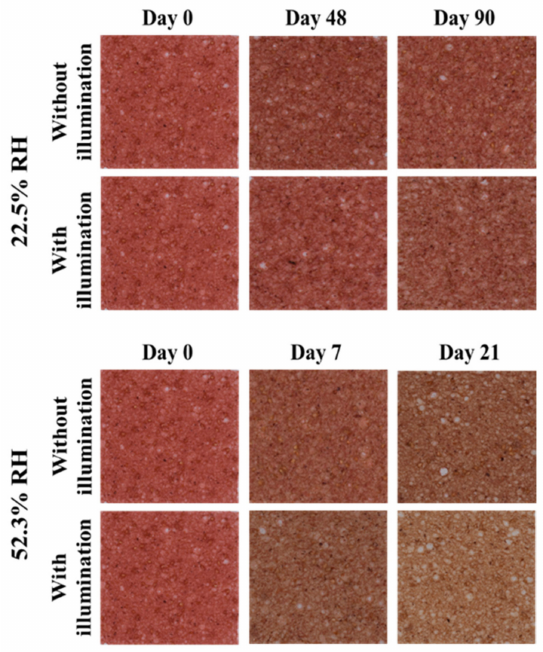
Figure 1. Evolution of color of the strawberry leather during storage. The instrumental color parameters ( L* , a* , and b* ) determined using CIELab color space and total color difference ( ∆ E* ) of the strawberry leathers are shown in Figure 2. The L* , a* , and b* values of the fresh sample (before storage) were 56.41 ± 2.38, 37.81 ± 2.13, and 21.85 ± 2.17, respectively. Abonyi et al. [36] reported similar results for the strawberry leathers obtained by Refractance Window drying. The L* and b* values remained constant during storage regardless of the RH and illumination, as shown in Figure 2(Ia,b,IIIa,b). As these parameters were not affected by the storage conditions ( p > 0.05), the kinetic model was not used to describe them. On the other hand, the a* value (redness) decreased throughout the storage time for all studied conditions ( p < 0.05). Buv é et al. [3], Garz ó n and Wrolstad [5], and Agudelo-Laverde et al. [37] reported similar behavior for these color parameters of strawberry products (strawberry juice and dehydrated strawberry) during storage. The a* value of the strawberry leather samples decreased faster during storage at the higher RH. Samples before storage showed an a* value of 37.81 ± 2.13, and after 90 days at 22.5% RH, this value decreased to 30.93 ± 1.76 and 31.08 ± 1.08, without and with illumination, respectively, while samples conditioned at 52.3% RH after 21 days showed an a* value of 22.74 ± 0.56 and 17.26 ± 0.67, without and with illumination, respectively. This result could be related to the anthocyanin degradation and non-enzymatic browning reactions, which are accelerated at higher water activities [37]. In general, the LED illumination did not influence the a* values of the strawberry leather samples during storage at 22.5% RH ( p > 0.05). However, samples conditioned at 52.3% RH with illumination presented a higher reduction of the a* values than those conditioned with no